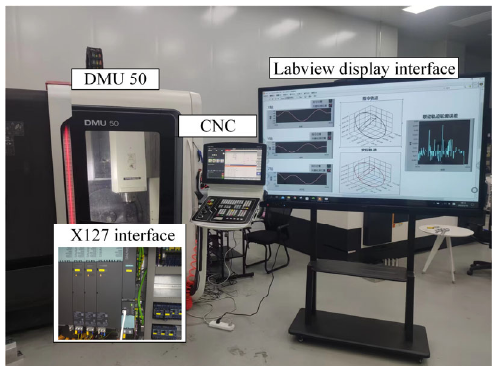
Figure 22. Experiment of real ‐ time prediction of contour error of DMU 50 five ‐ axis machine tool.